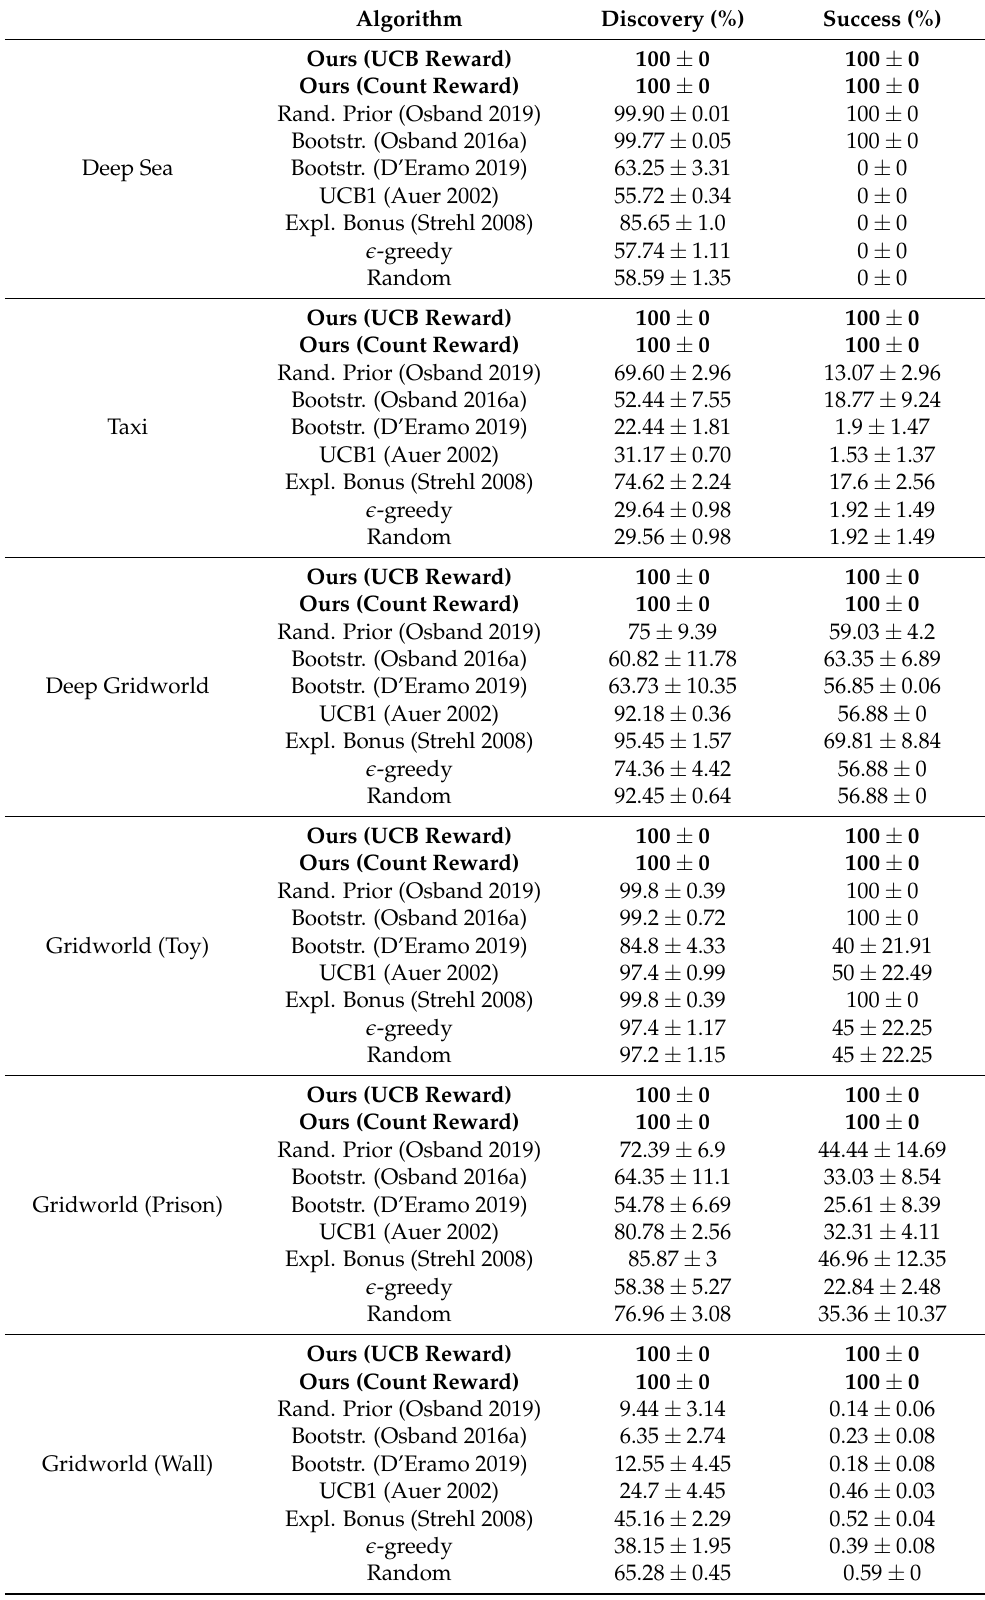
Table 1. Results recap for the “zero initialization short horizon”. Only the proposed exploration strategy always discovers all states and solves the tasks in all 20